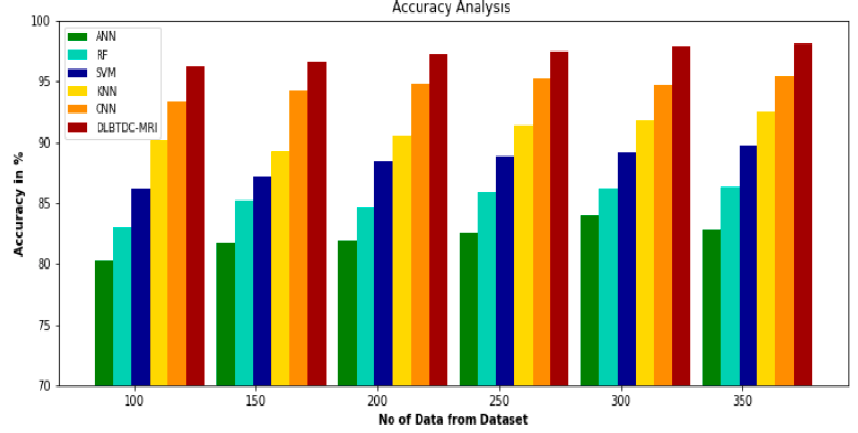
Figure 5. Accuracy analysis of DLBTDC-MRI method with existing system. Figure 4. Accuracy analysis of DLBTDC-MRI method with existing system. Table 2. Accuracy analysis of DLBTDC-MRI method with existing system.